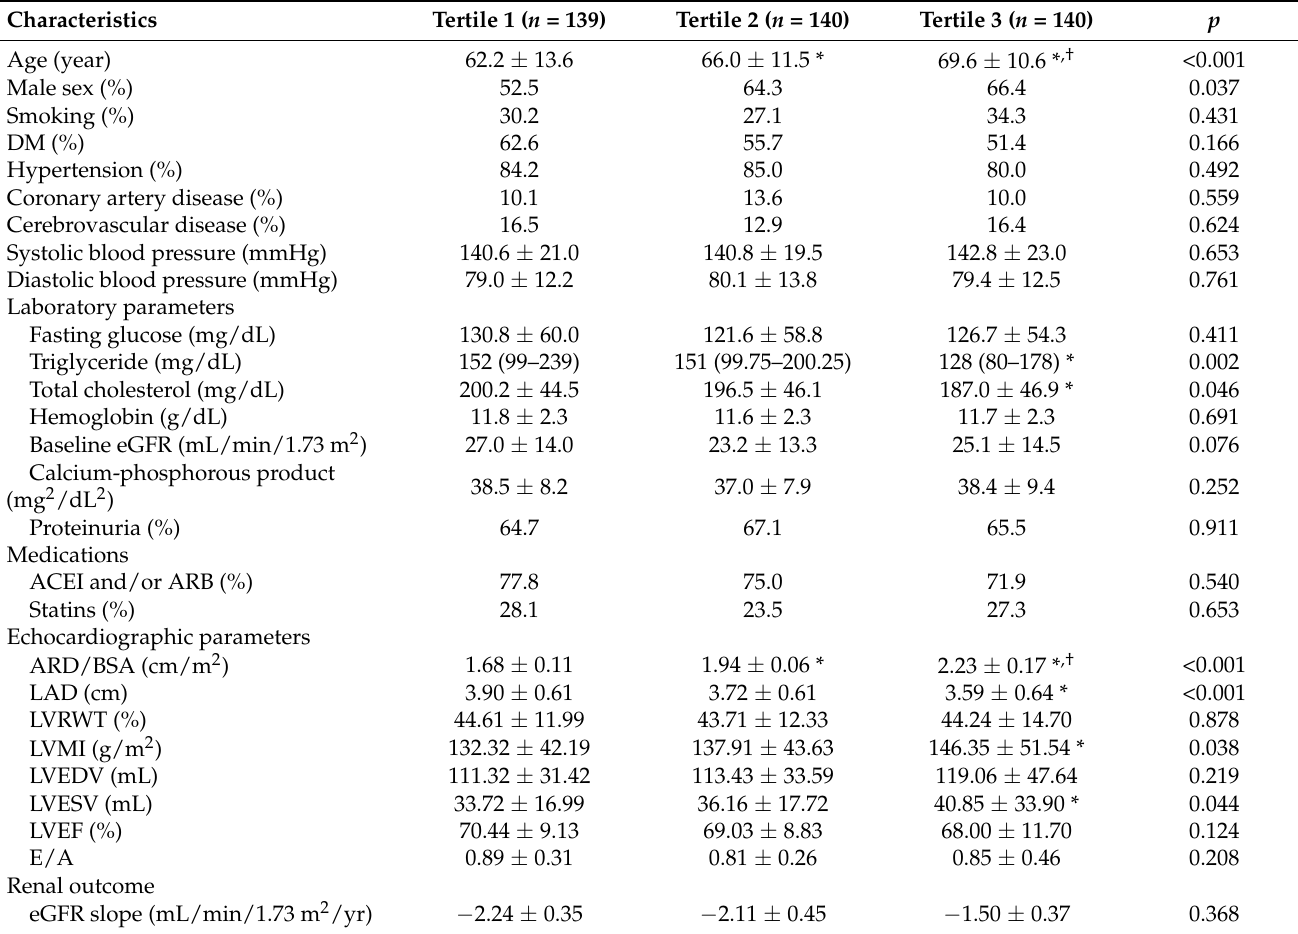
Table 1. Comparison of clinical characteristics between the groups according to ARD/BSA tertile.